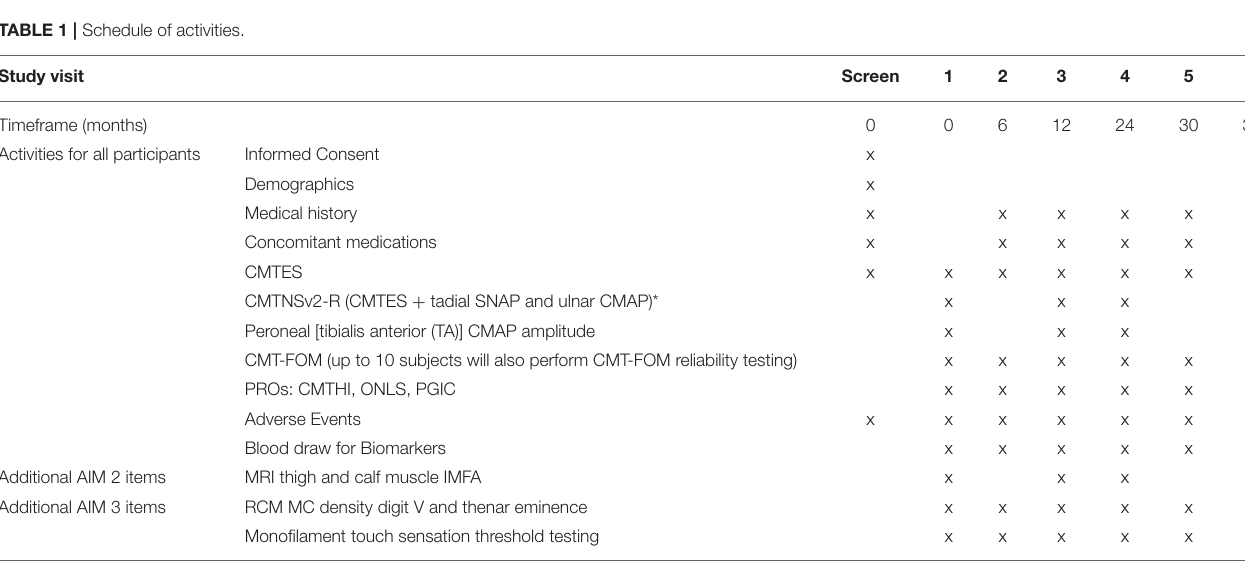
TABLE 1 | Schedule of